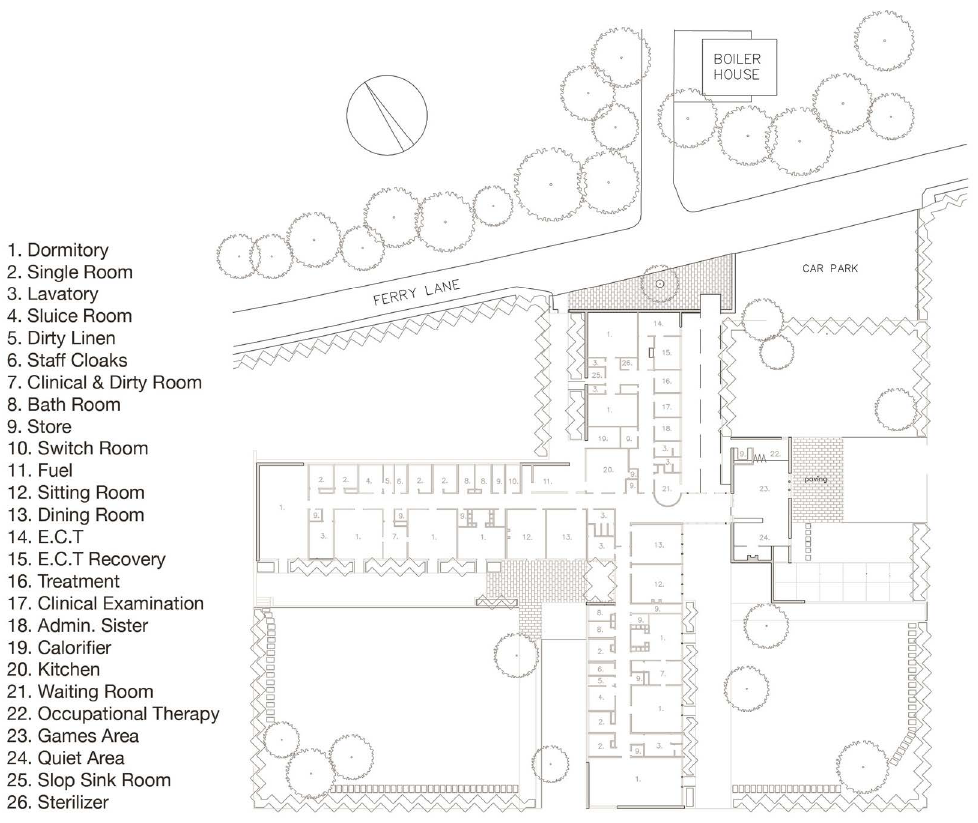
Figure 3. Admission and Treatment Unit, Fair Mile Hospital, Wallingford, Oxfordshire, floor plan, 1956 (Source: plan redrawn by Alex